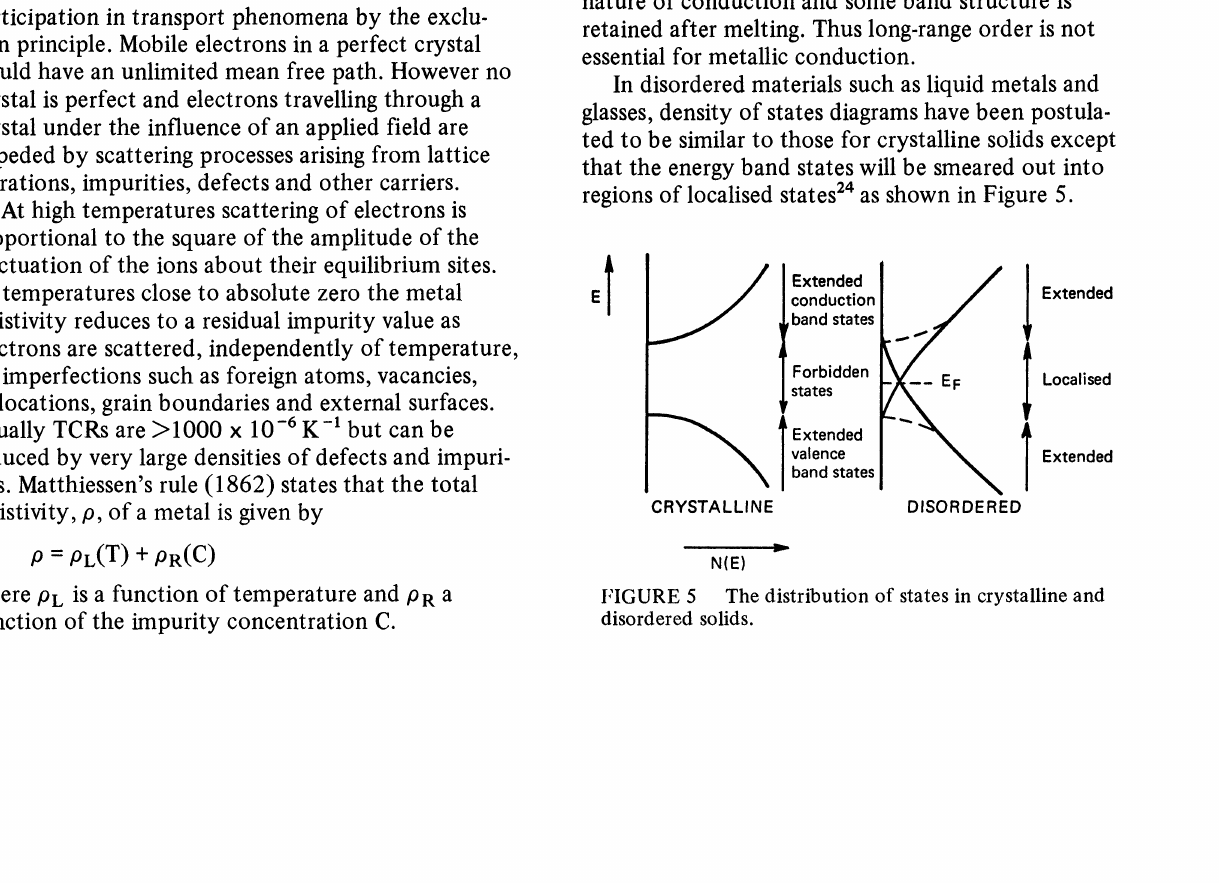
The distribution of states in crystalline and disordered